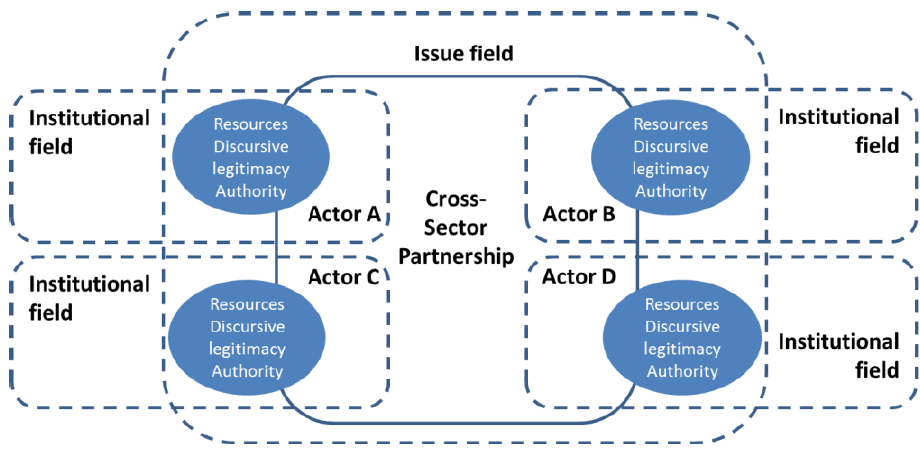
Figure 1. Power sources at the intersection of issue field and institutional fields .